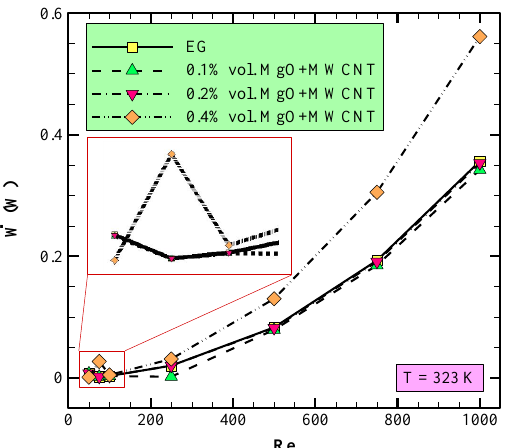
Figure 14. Influence of HNF with different VF on hydraulic power for different Re and inlet temperature T = 323 K.